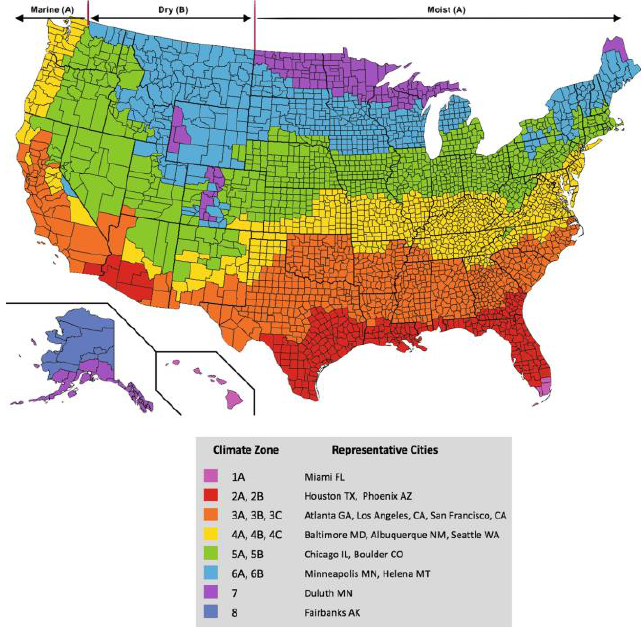
Figure 3. U.S. climatic zoning map [20].